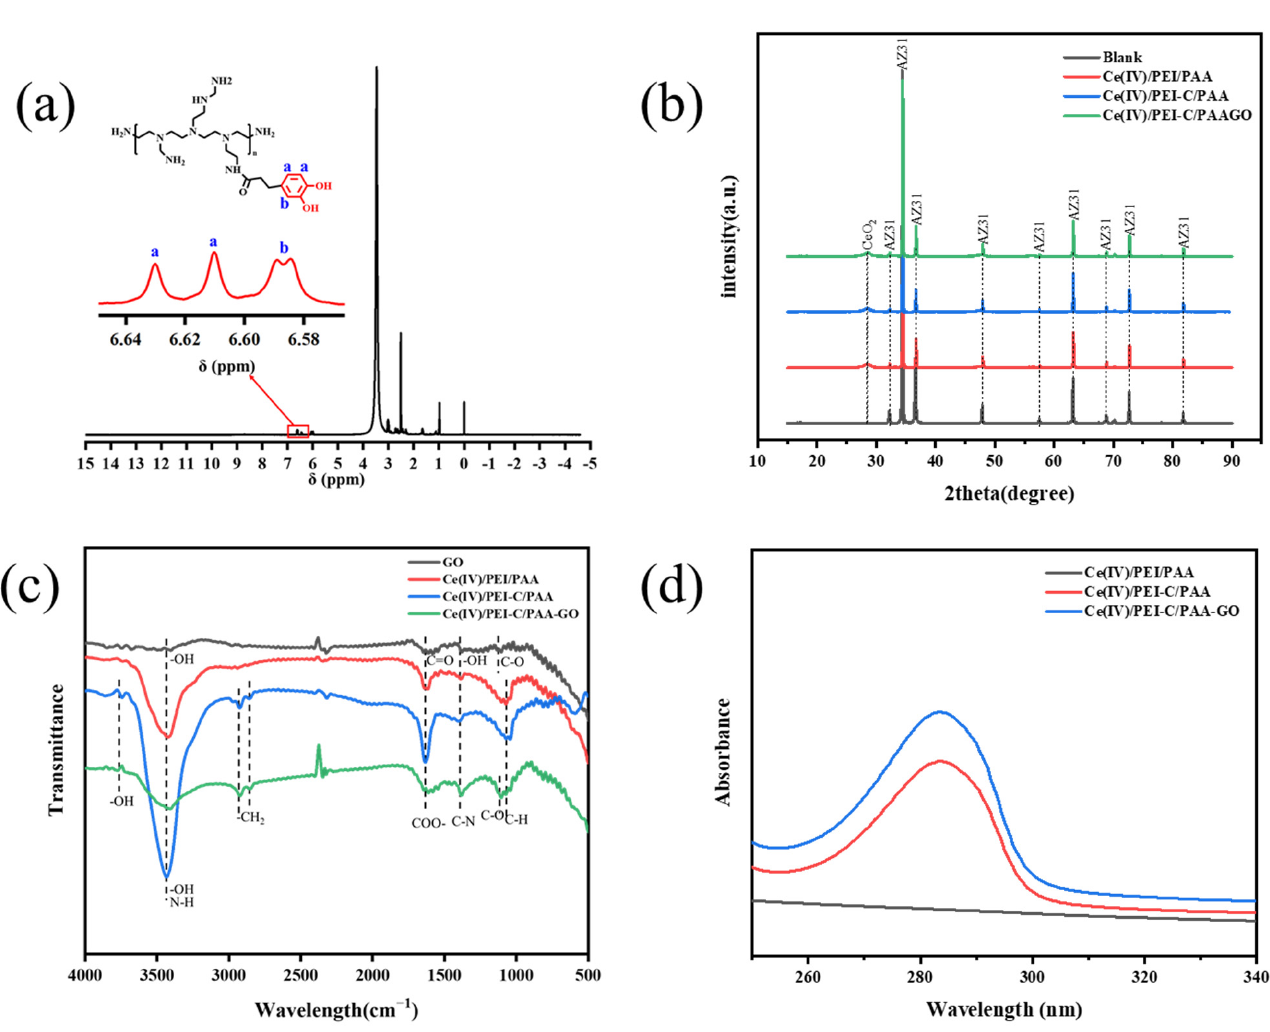
Figure 4. The compositional characterization of the different patterns of: ( a ) 1 H NMR of PEI-C, ( b ) XRD, ( c ) FT-IR, and ( d ) UV-Vis.